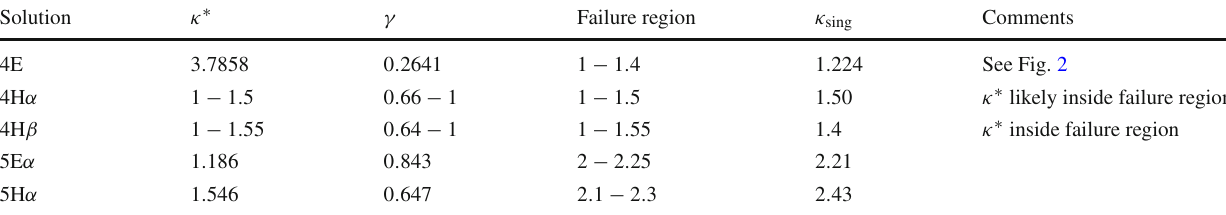
Table 3 Partial results for the Choptuik exponents for the 4 and 5 dimensional elliptic and hyperbolic classes